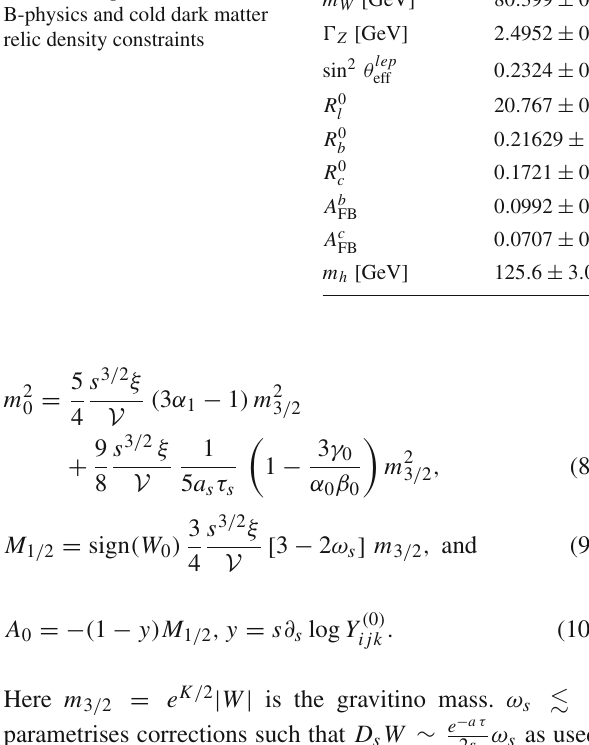
Table 1 Summary for the central values and errors for the electroweak precision, B-physics and cold dark matter relic density